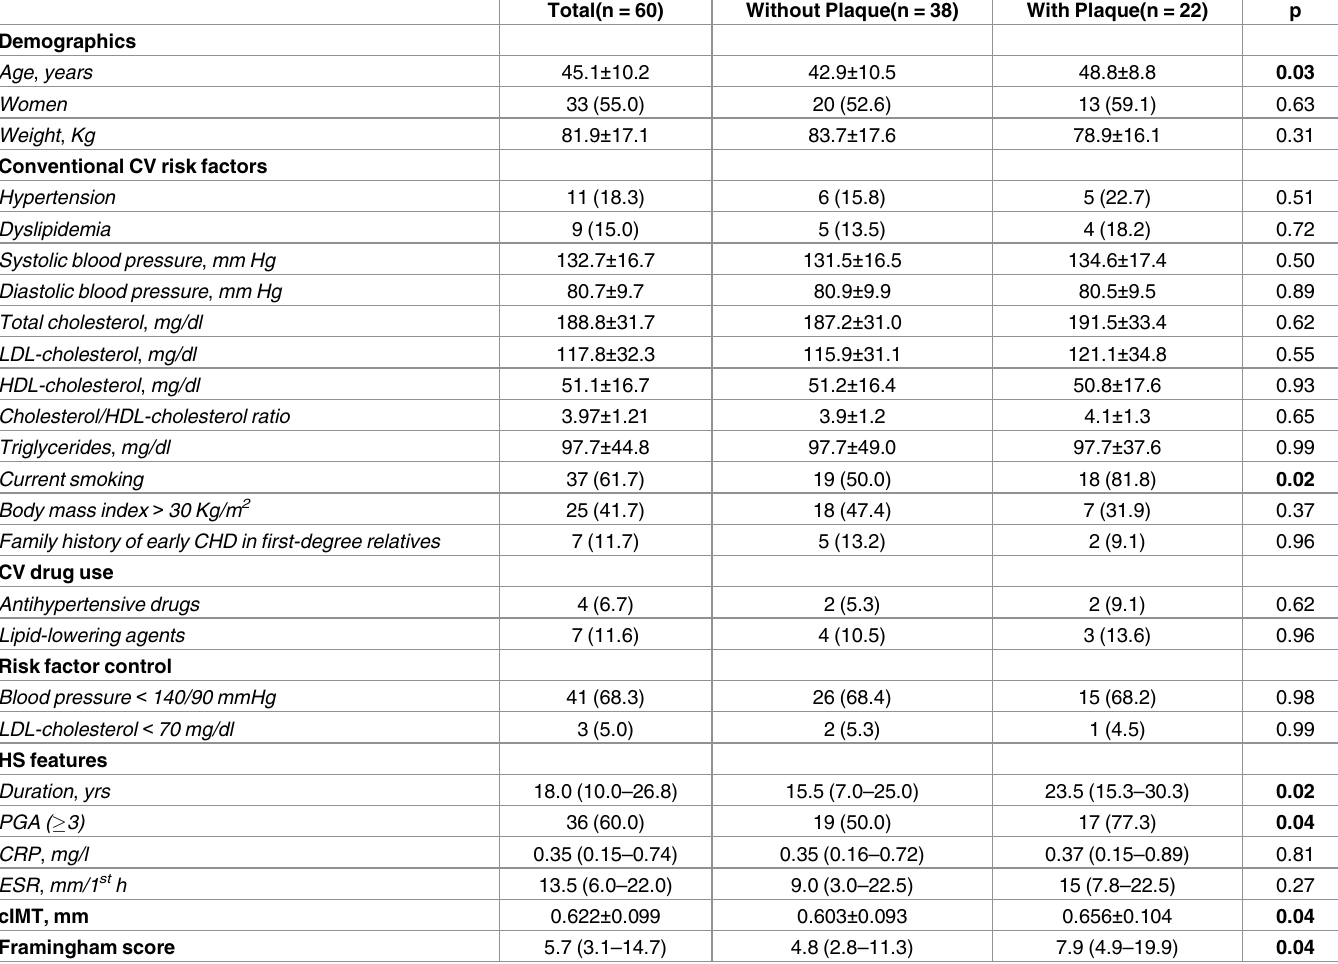
Table 1. Baseline featuresof HS patients according to the presence of carotid